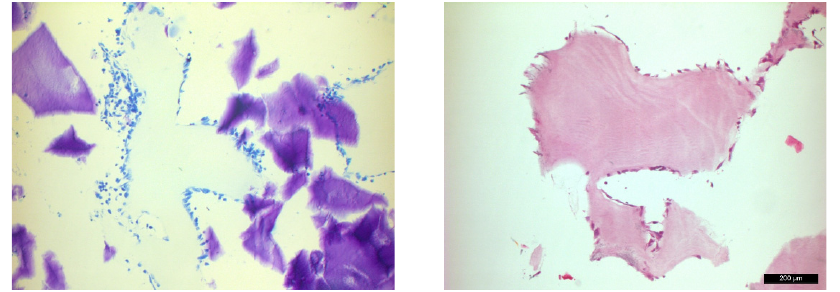
Figure 5. Toluidine blue staining of SAOS-2 cells adhered to the substrate B after 14 days ( left ) and hemalum-eosin staining of SAOS-2 cells on the same substrate B ( right